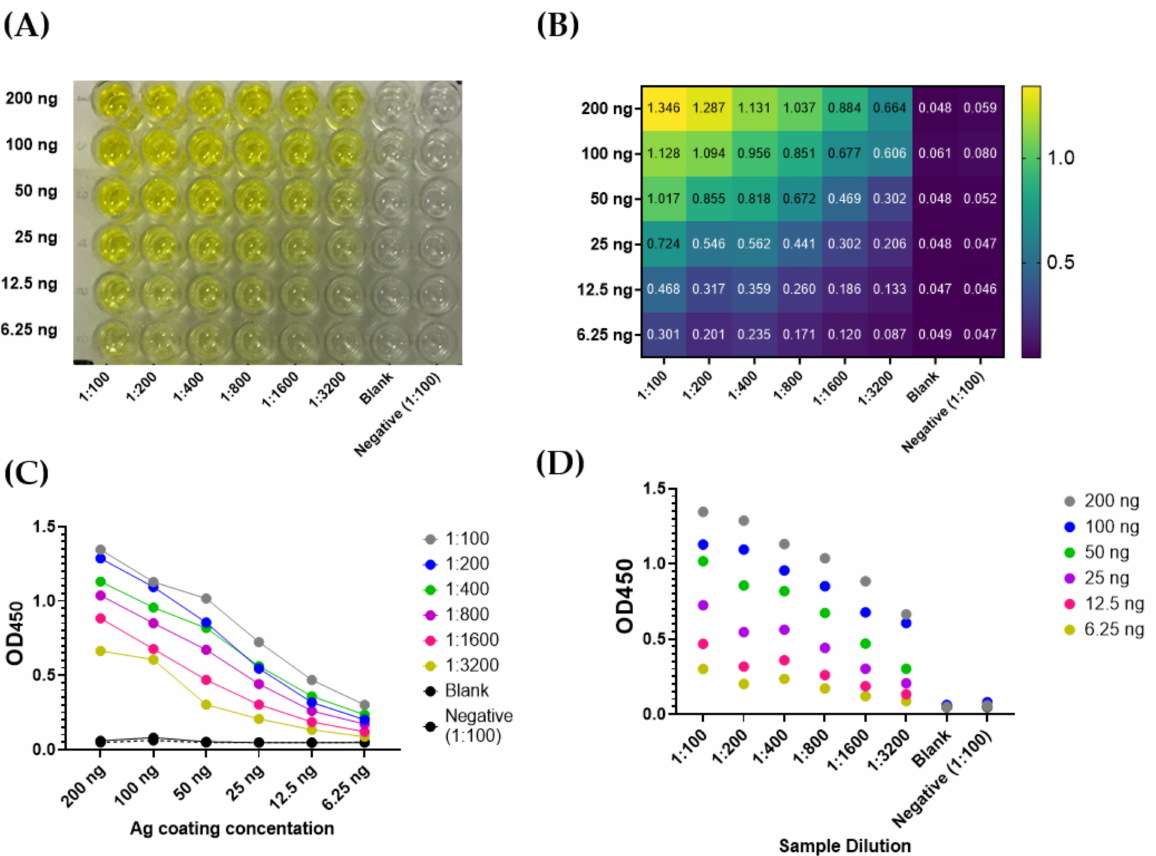
Figure 1. Optimization of an indirect ELISA utilizing SARS-CoV-2 NP recombinant protein. The assay was conducted as described in Section 2.3. ( A ) A representative image of results obtained at a range of SARS-CoV-2 NP coating concentration (6.25 to 200 ng) and a positive sample dilution (1:100 to 1:3200). Negative control and blank were also included. ( B ) Repre- sentative OD450 readings. ( C , D ) The effect of antigen (Ag) coating concentration and sample dilution on signal